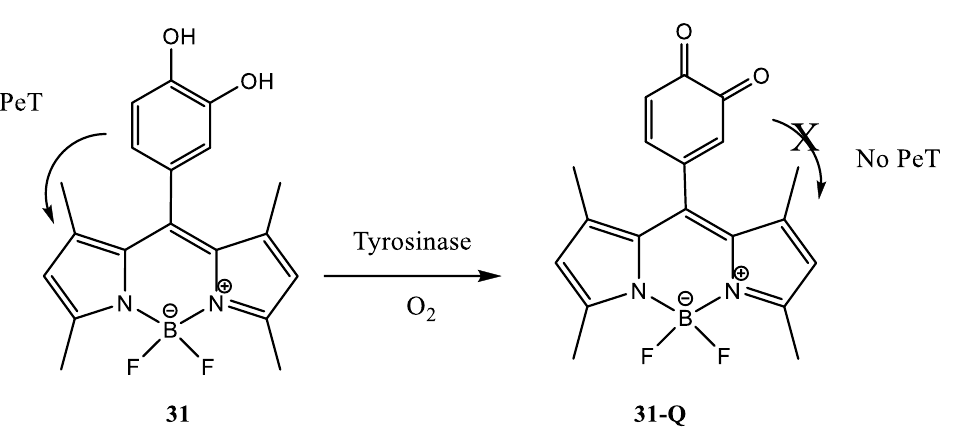
Figure 7. Nucleophilic[ 18 F]-radiolabeling of a BODIPY dye.